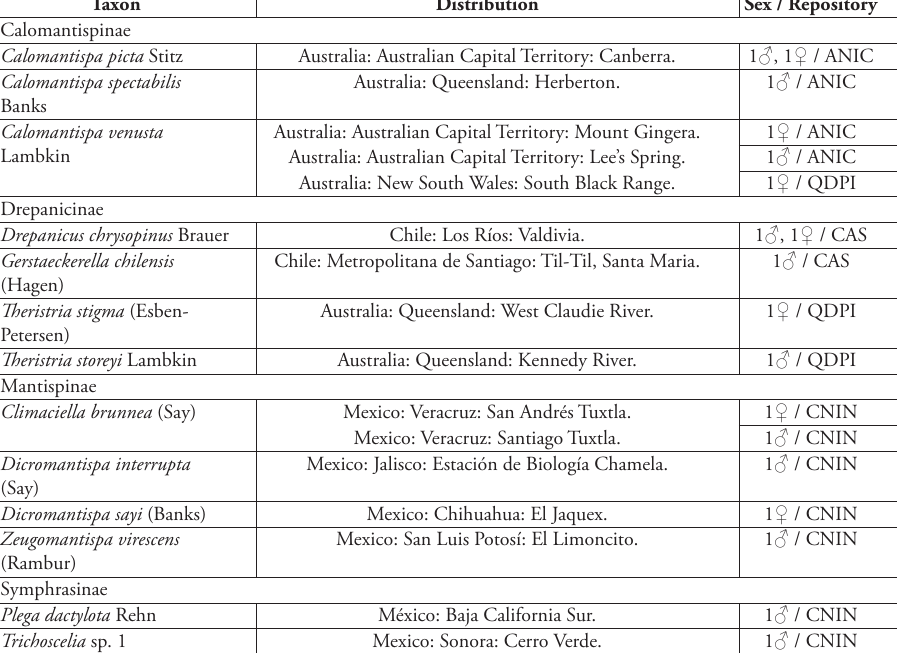
Table 1. Comparative taxa examined to establish diagnostic features of the genus Nolima